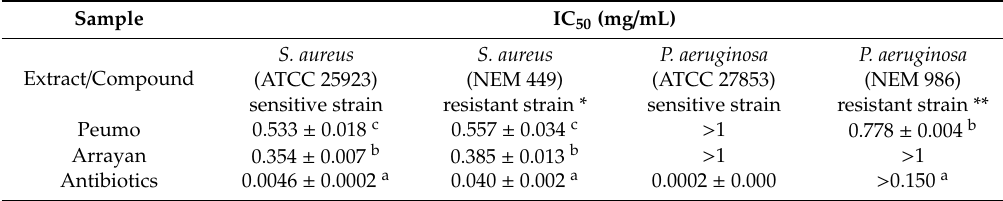
Table 1. Inhibition of multidrug-resistant bacterial strains. Commercial antibiotics oxacillin or gentamicin served as the positive controls for S. aureus and P. aeruginosa , respectively.